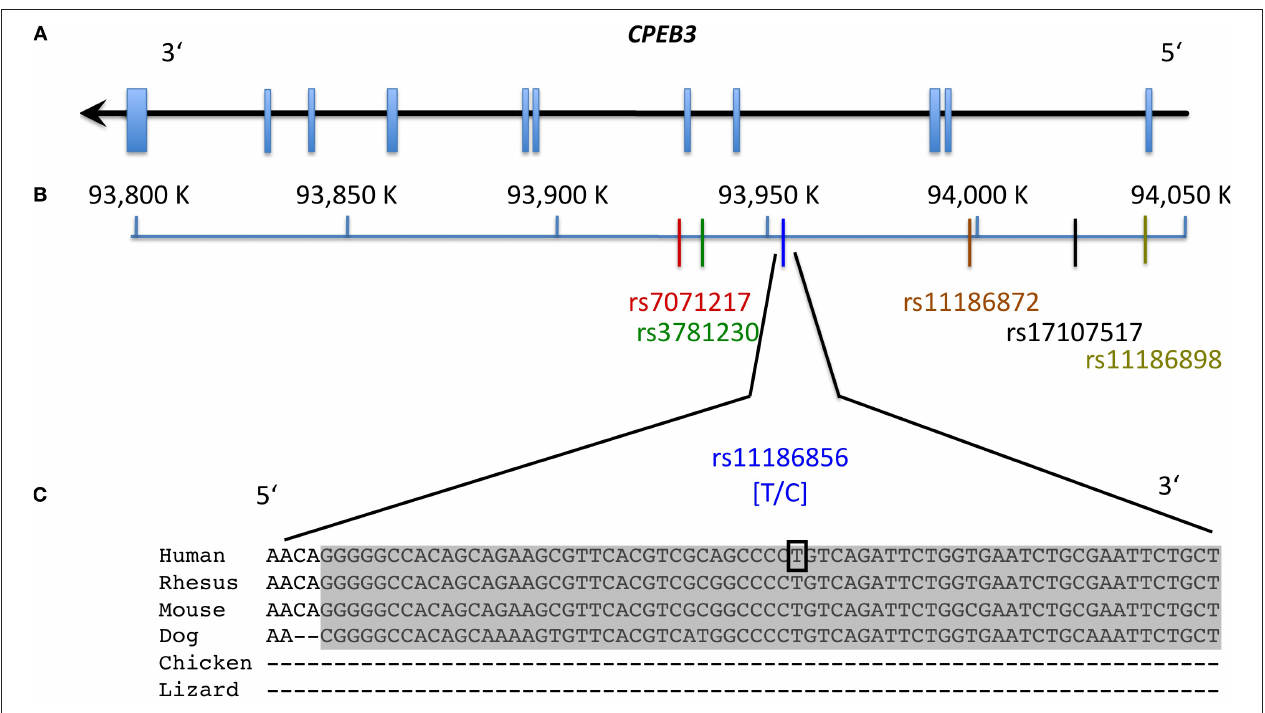
shown as part of intron 3. The alignment of the mammalian ribozymes with the human sequence demonstrates a high degree of conservation. Shaded grey area corresponds to the minimum active ribozyme sequences. The position of the human SNP rs11186856 is indicated by a